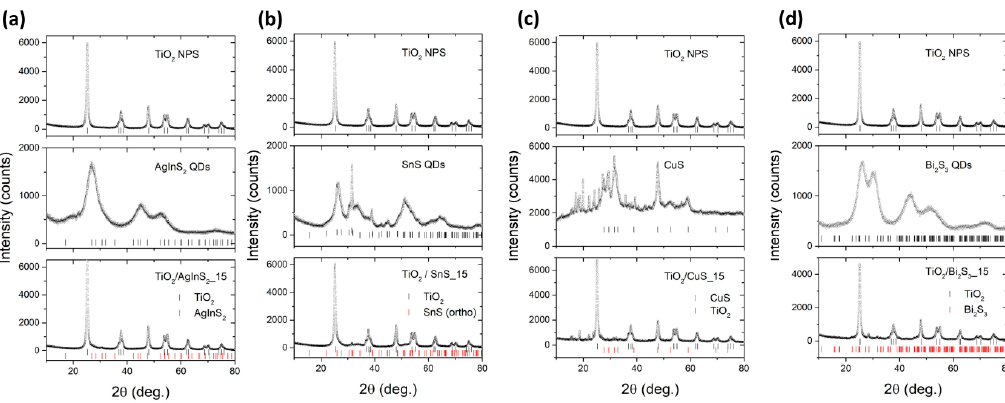
Figure 5. XRD analysis for ( a ) TiO 2 , AgInS 2 and TiO 2 /AgInS 2 _15, ( b ) TiO 2 , SnS and TiO 2 /SnS_15, ( c ) TiO 2 , CuS 2 and TiO 2 /CuS_15, ( d ) TiO 2 , Bi 2 S 3 and TiO 2 /Bi 2 S 3 _15.